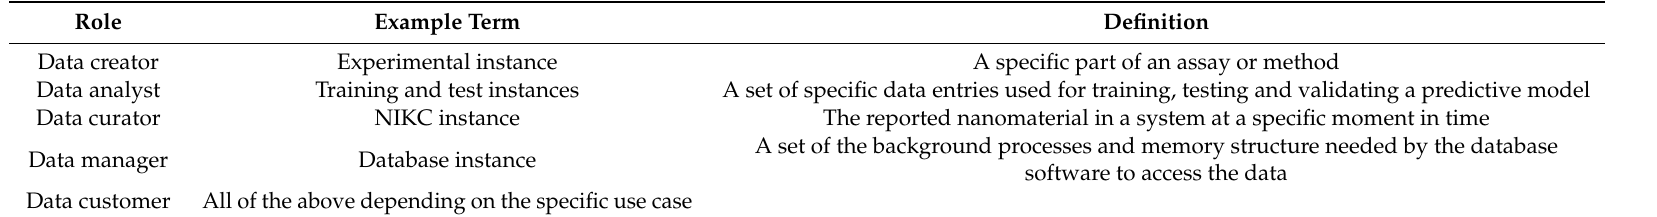
Table 2. Definition of the term “instance” for data creators, analysts, curators, managers, and